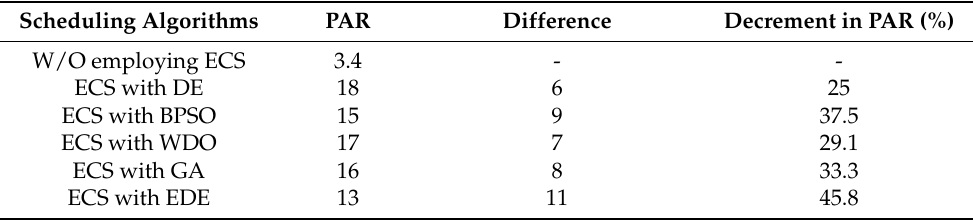
Figure 21. Hybrid load PAR evaluation. Table 11. Numerical results of PAR after scheduling hybrid